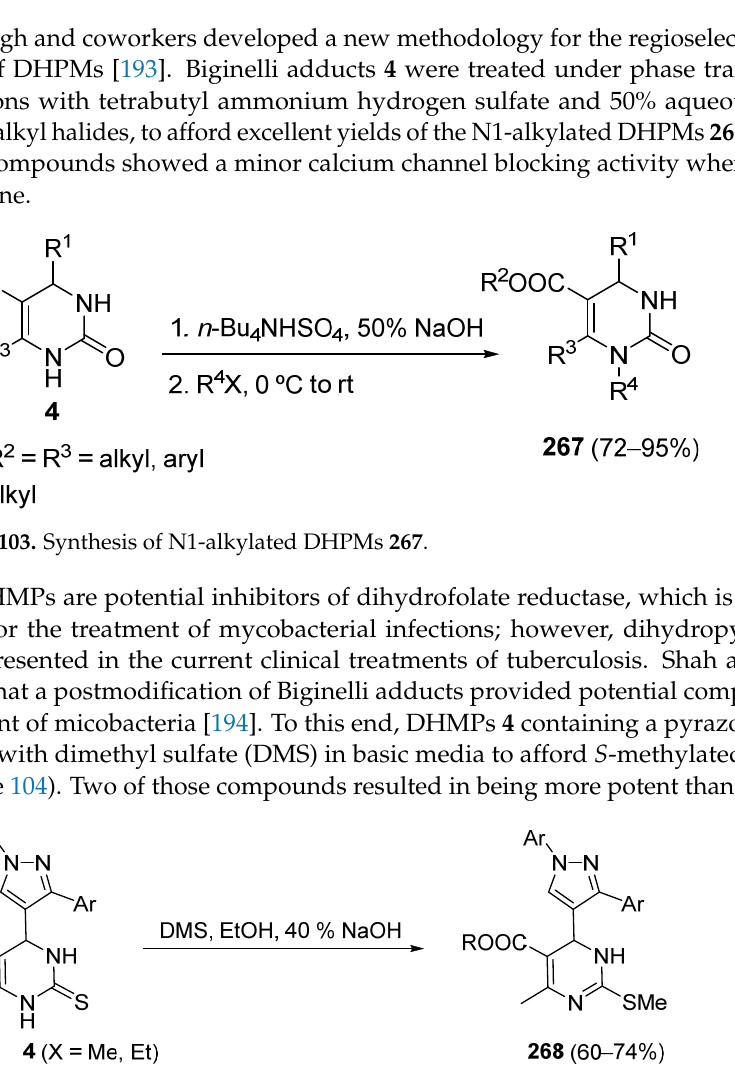
Scheme 102. Derivatization of enantiomerically enriched DHPM 4 for the synthesis of ( S )-L-771688.